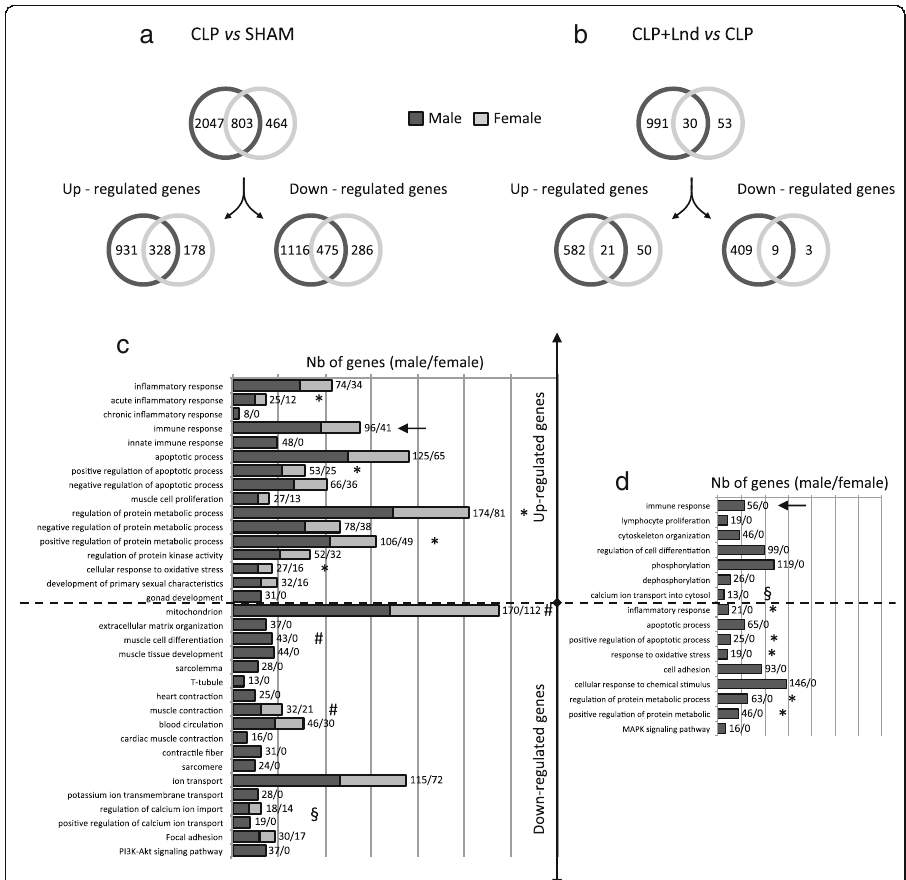
Fig. 1 Differentially expressed genes (DEG) in male and female hearts after cecal ligation and puncture and landiolol. DEG were obtained after 2-class significance analysis of microarrays (SAM) 2 classes in TMeV, 10,000 permutations with an FDR < 0.01 for CLP vs sham ( a ) and with an FDR < 0.05 for CLP plus landiolol vs CLP groups ( b ). a , b Venn diagrams show the total number of DEG and the number of genes significantly up- and down-regulated in CLP ( a ) and CLP plus landiolol groups ( b ). The number of specific genes in females is very low compared to males. c , d A gene ontology analysis realised with the DAVID Database is reported on graphs in which the most significant biological process (BP)-GO terms for up- and down-regulated genes are indicated for CLP vs sham groups ( c ) and for CLP plus landiolol vs CLP groups ( b ). For all the processes, the number of genes deregulated in males is much greater than in females. Note the total absence of significant biological processes for females after landiolol infusion in ( d ). (*) indicates over-expressed biological processes during CLP that were reversed by landiolol. (§) indicates under- expressed biological processes during CLP that were reversed by landiolol. (#) indicates under-expressed biological processes related to cardiac activity and cardiomyocyte function that were affected during CLP and were not restored by landiolol. ( ← ) shows that the immune response is over-expressed during sepsis and potentiated by landiolol. ( N = 5 – 6 per group). CLP cecal ligation and puncture, CLP + Lnd CLP plus landiolol, Nb of genes number of apoptosis, metabolism, oxidative stress, muscle cell proliferation, protein kinase activity and the development of primary sexual features. For down-regulated genes, the bio- logical processes were related to mitochondrion, muscular cell organisation (organelles, myocyte membrane and contractile proteins), muscle contraction, blood circulation, ionic transport and phosphoinositide-3-kinase/AKT (PI3K/AKT) signalling pathway. These changes in gene expression were predominantly found in males (Fig. 1c, Additional file 3: Table S1). For example, in the male CLP group, the transcript levels of the Janus kinase/signal transducer and activator of transcription (JAK/STAT)